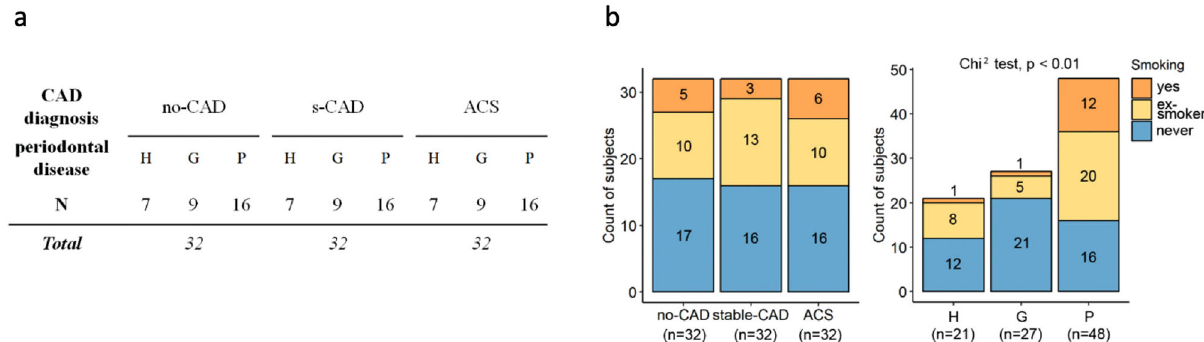
Fig. 1 Characteristics of the clinical cohort. a Subjects divided in three groups based on CAD diagnosis (no-CAD, stable-CAD (s-CAD), or ACS). Total , size of the group. Each of the three CAD groups included subjects with different periodontal health diagnosis: periodontally healthy (H), patients with gingivitis (G) – a transient gum in fl ammation – , or patients with periodontitis (P). N , size of the sub-group. b Signi fi cant association between periodontal diagnosis and smoking is observed in the study cohort. Frequency distribution graphs of subjects ( n = 96) in groups with coronary artery health condition (no-CAD, stable-CAD, or ACS) or periodontal condition (H, G, P). Statistically signi fi cant difference in prevalence of cigarette smoking was observed in periodontal condition groups, being highest among the periodontitis group subjects, but not within CAD groups (Chi 2 test, p value < 0.05, n = 96 independent subjects). x-axes – clinical subgroups; y-axes – number of subjects; color- fi ll – yes , active cigarette smoker (orange); ex-smoker , has quit cigarette smoking (yellow); never , no history of cigarette smoking (blue)